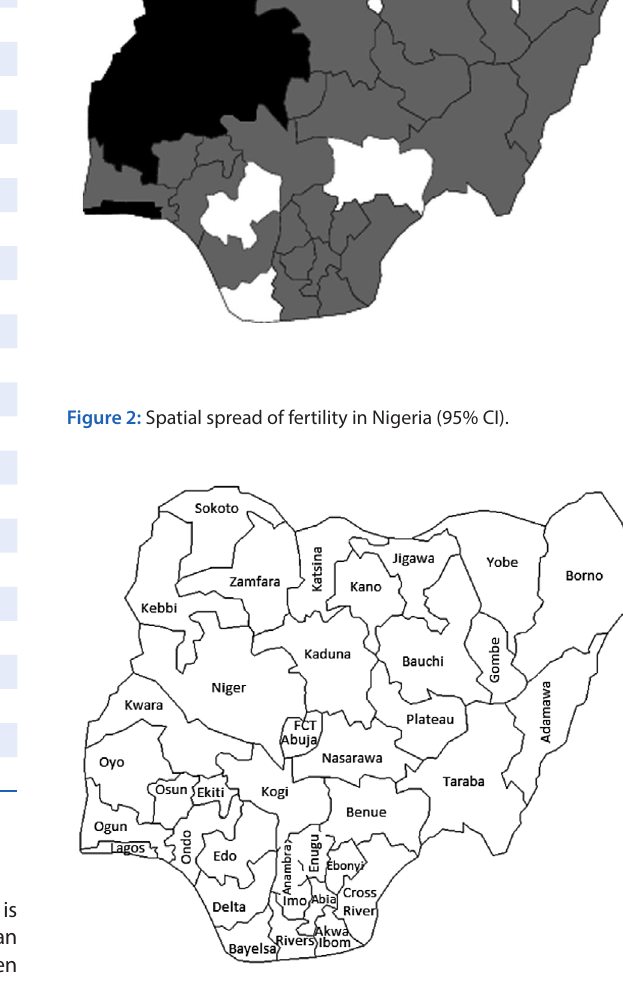
Figure 3: Labelled map of